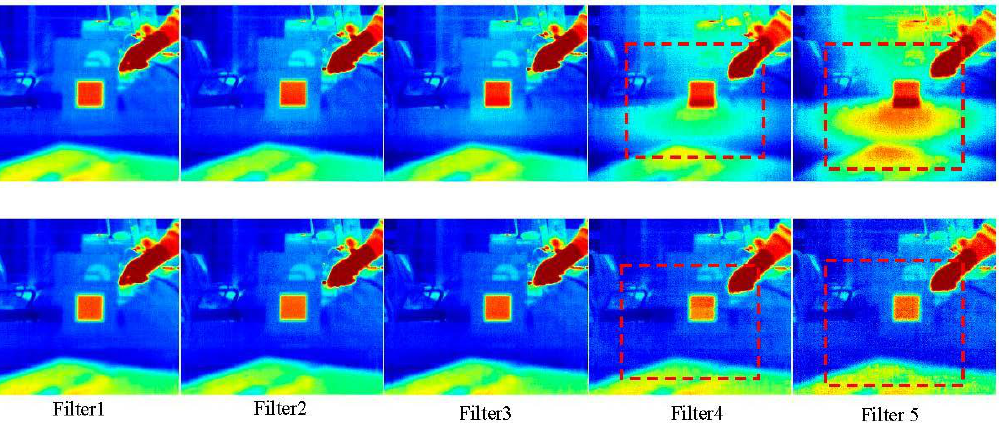
Figure 4. The upper and lower row figures are thermal images before and after correction, respectively. The dashed-line rectangles in filters 4 and 5 show the uneven effect of the filter, and, in the lower row, clear images in the rectangle areas show the correction effect.